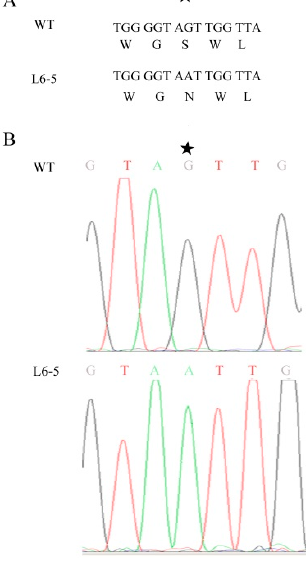
Figure 7. The SNP of Sme2.5_06210.1_g00004 between the wild type and L6-5. ( A ) The SNP of Sme2.5_06210.1_g00004.1 at the 785bp (G–A), which results in the amino acid Ser mutant to Asn, ( B ) Sanger sequencing identified the SNP. The asterisk indicates the SNP.